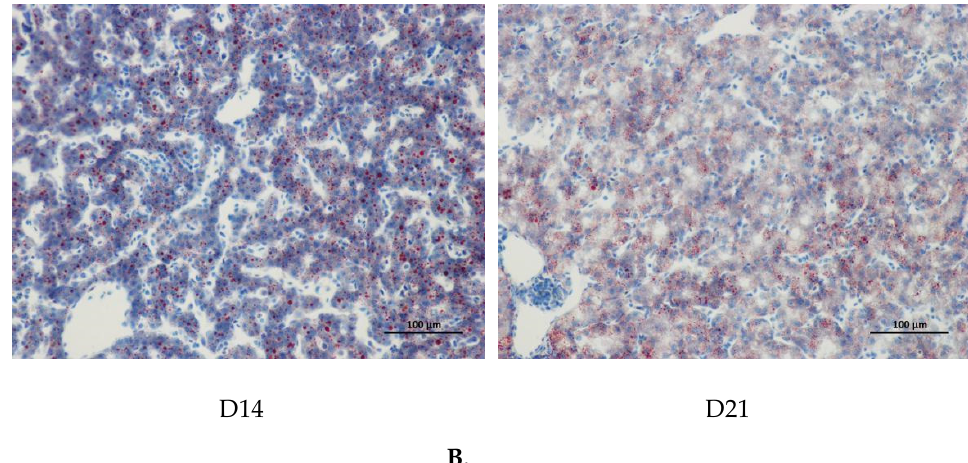
Figure 6. The age-related changes in hepatic lipid accumulation of domestic pigeon squabs. DOH = day of hatch; D7 = day 7 post-hatch; D14 = day 14 post-hatch; D21 = day 21 post-hatch. ( A ) Oil-Red-O staining area was measured using the Image-pro plus 6.0. Values are means ± SEM of 10 squabs, n = 10. a,b Means sharing no common superscripts differ significantly (Tukey test, p < 0.05). ( B ) Representative Oil-Red-O staining of livers in the four experimental groups. Bar = 100 μ m.